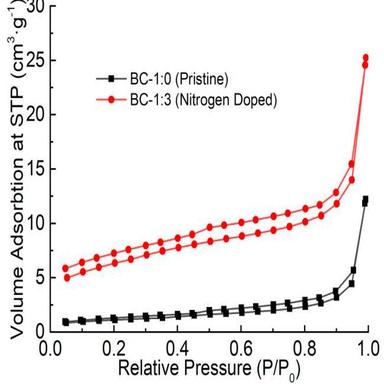
Nitrogen adsorption–desorption isotherm of intrinsic (BC-1:0) and nitrogen doped (BC-1:3) biocarbon samples.